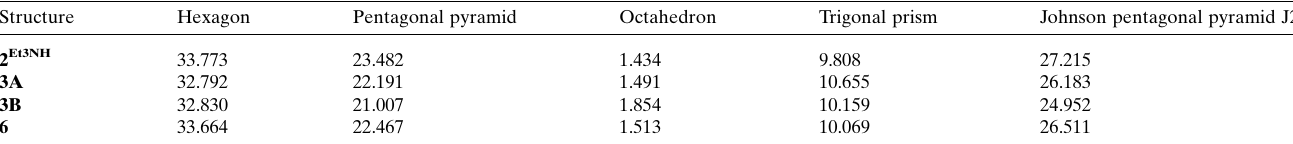
Table 1 Continuous shape measures (CShM’s) relative to ideal reference octahedral symmetry for 2 Et3NH , 3 and 6 .